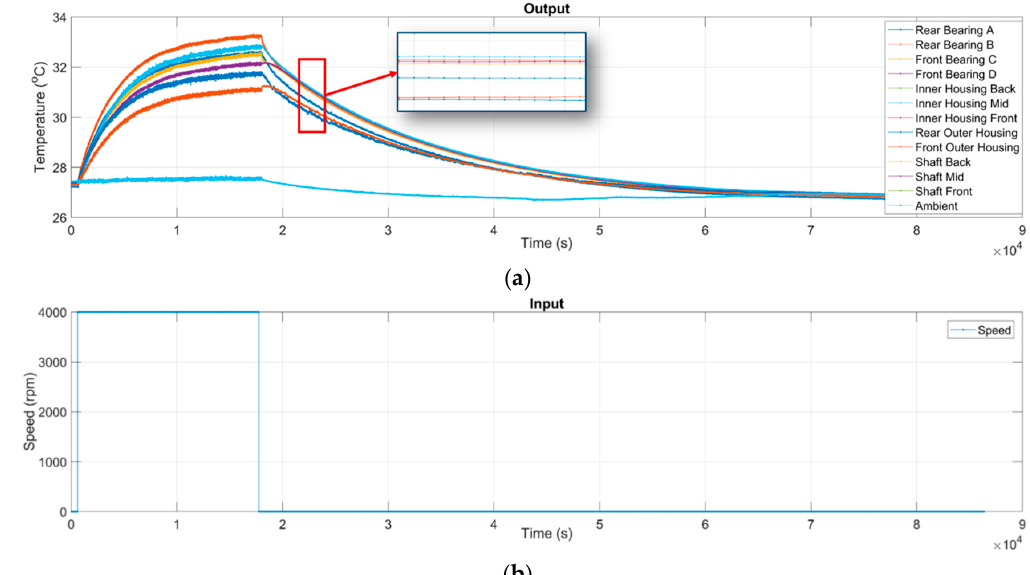
Figure 11. Resampled data with the same sampling rate of 1 Hz: ( a ) The time-series of temperatures resampled from the raw data; ( b ) The time-series of the input rotational speed of the spindle resampled from the raw data. Given the case of 4000 rpm as an example.